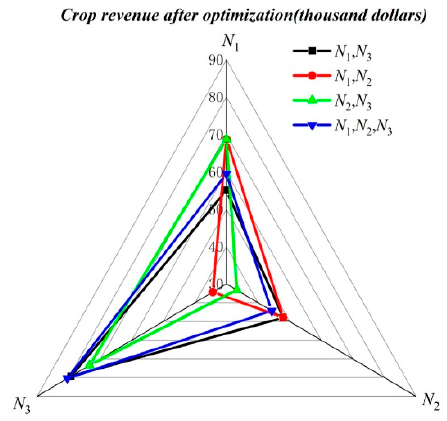
Figure 7. Crop revenue after optimization.